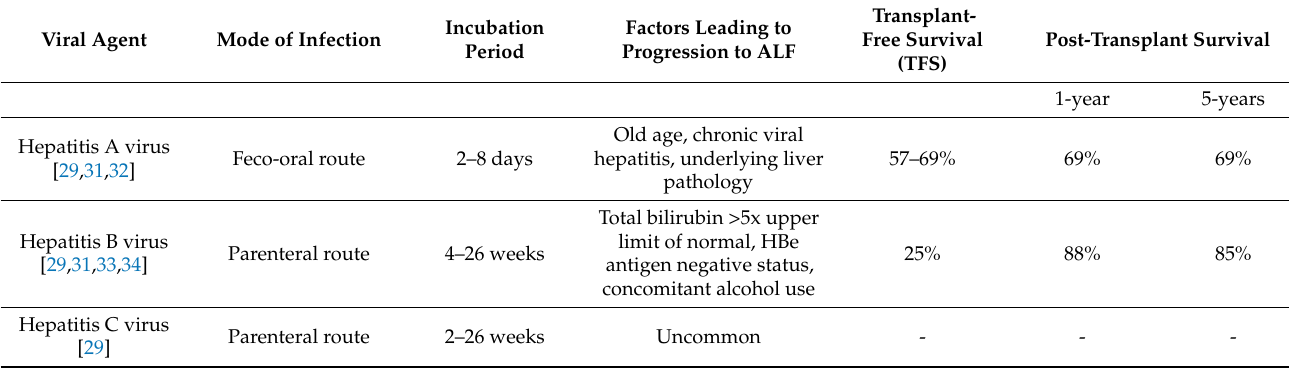
Table 3. Clinical outcomes of acute viral hepatitis-related acute liver